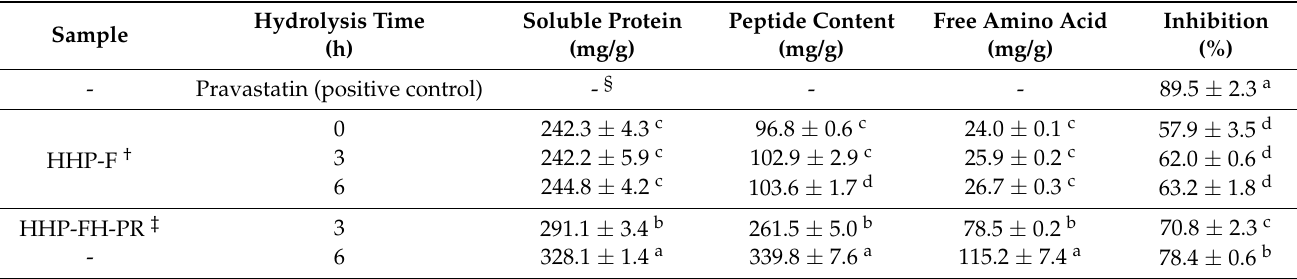
Table 2. Effect of proteases and HHP conditions on soluble protein, peptide, and free amino acid content and HMG-CoA reductase inhibitory activities of lactic fermented spirulina hydrolysates